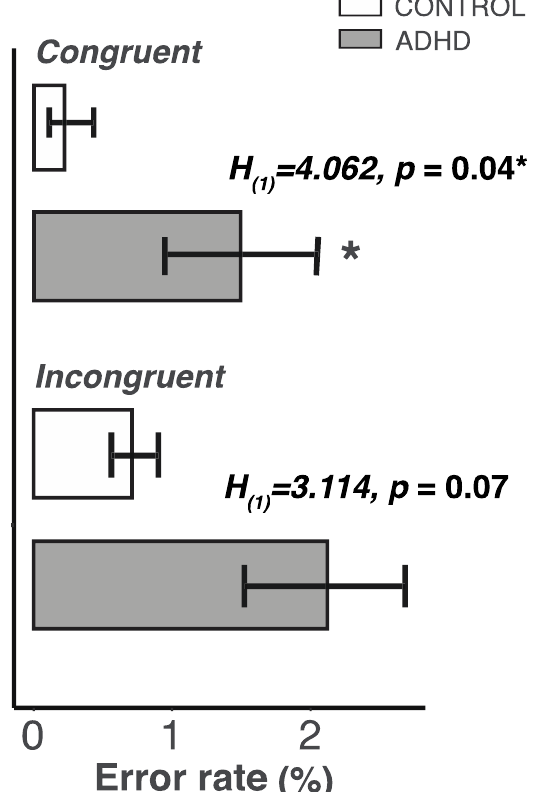
Figure 2. Participants with ADHD showed higher rates when they faced arrows pointing in the same direction (congruent condition). Open bars represent participants without ADHD and grey bars represent subjects with ADHD. Data is presented as mean with standard error bar. An asterisk indicates a significant higher error rate in ADHD than CONTROL group at a p level of 0.05.